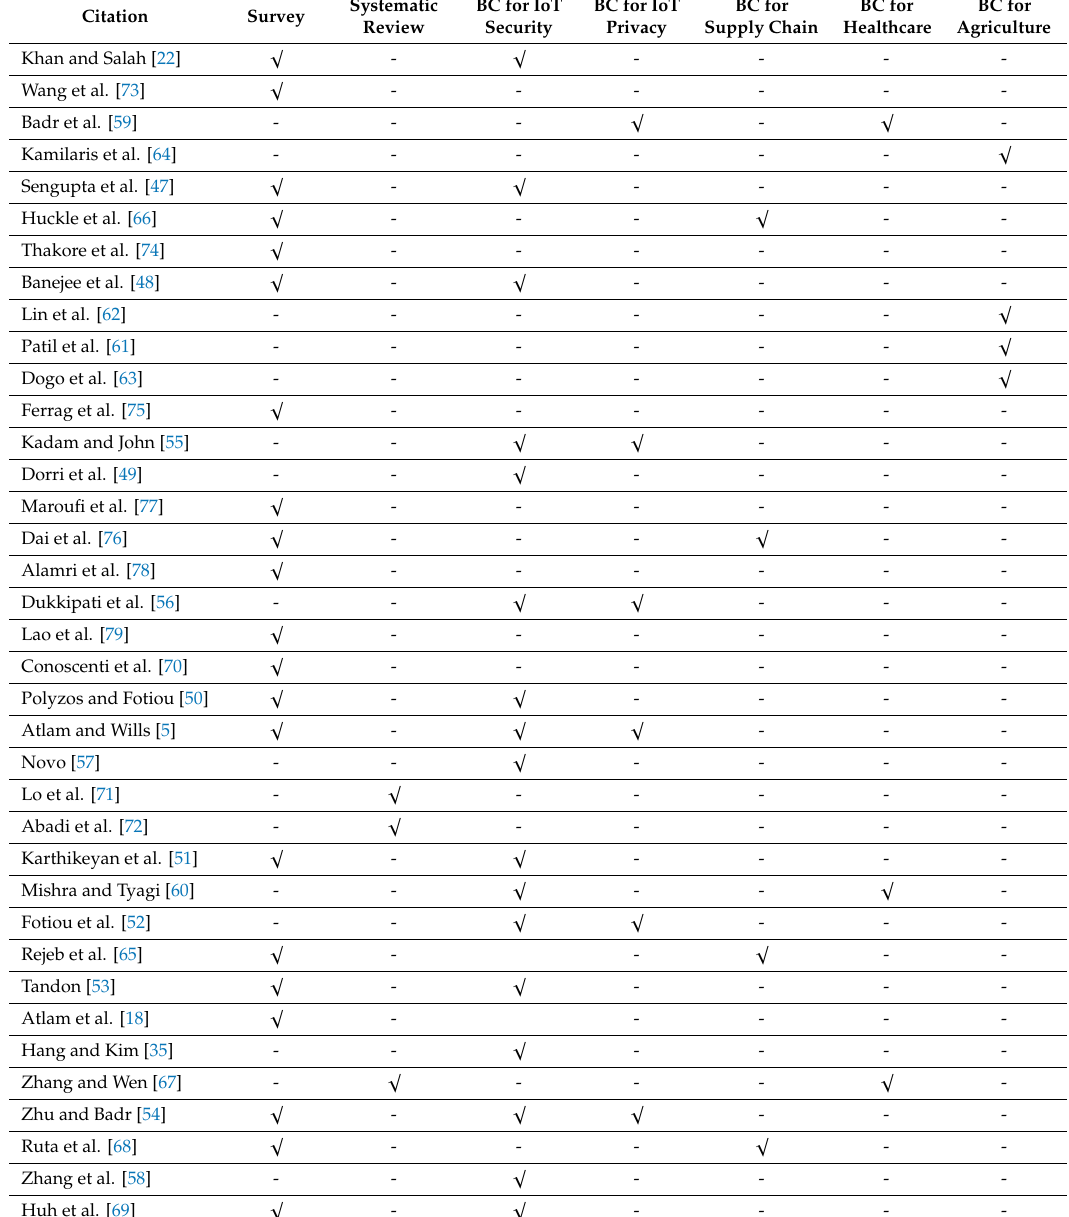
Table 6. Categorisation of the recent studies of blockchain (BC) with